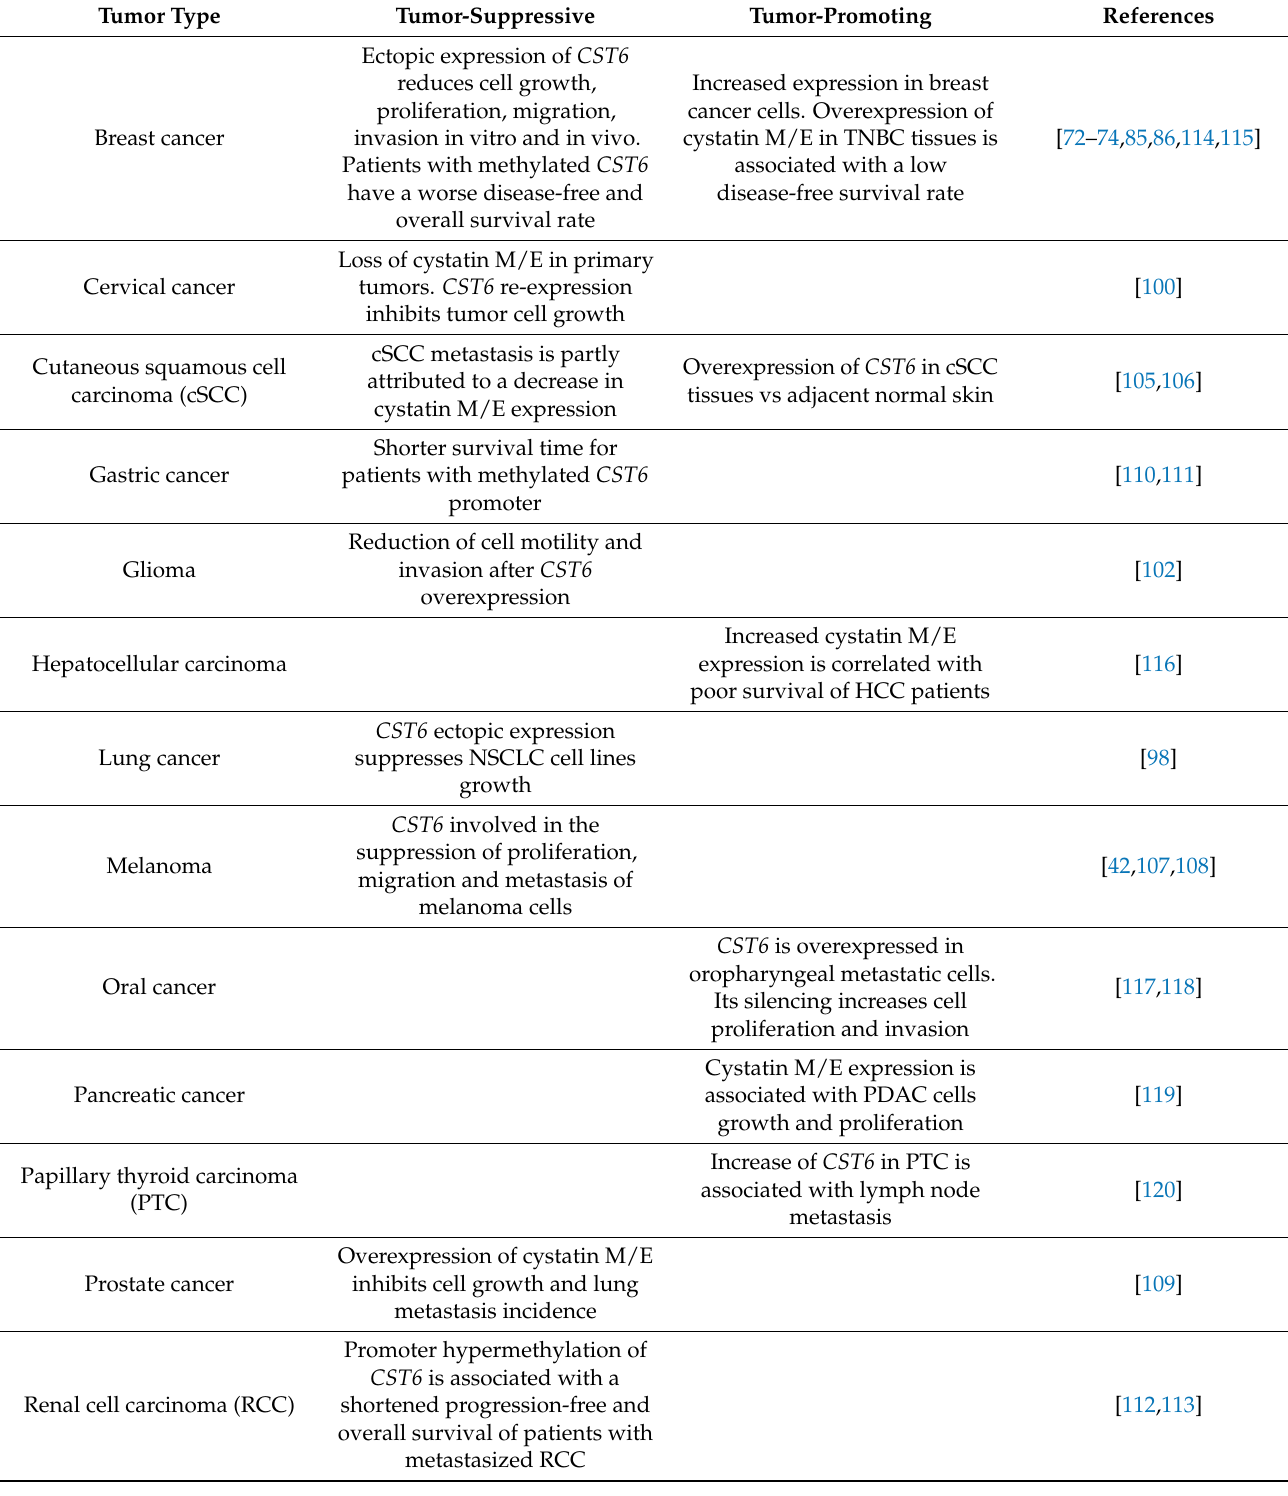
Table 2. Roles of cystatin M/E ( CST6 ) in cancer—a short